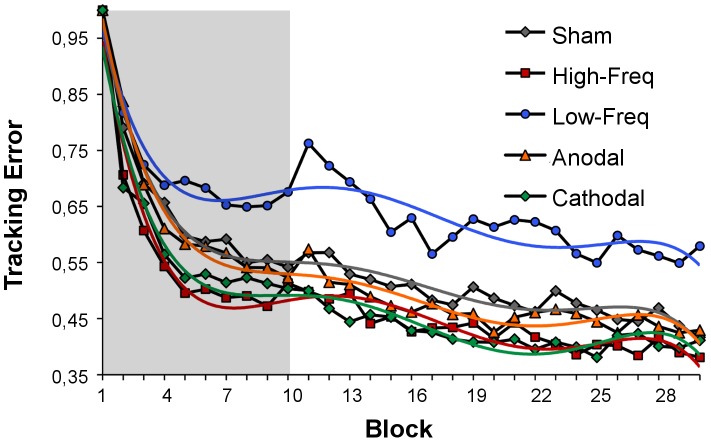
Changes in tracking error relative to the first trial.Shaded area corresponds to the stimulation period. Fifth Polynomial trendlines are superimposed on the data for easier visualization.